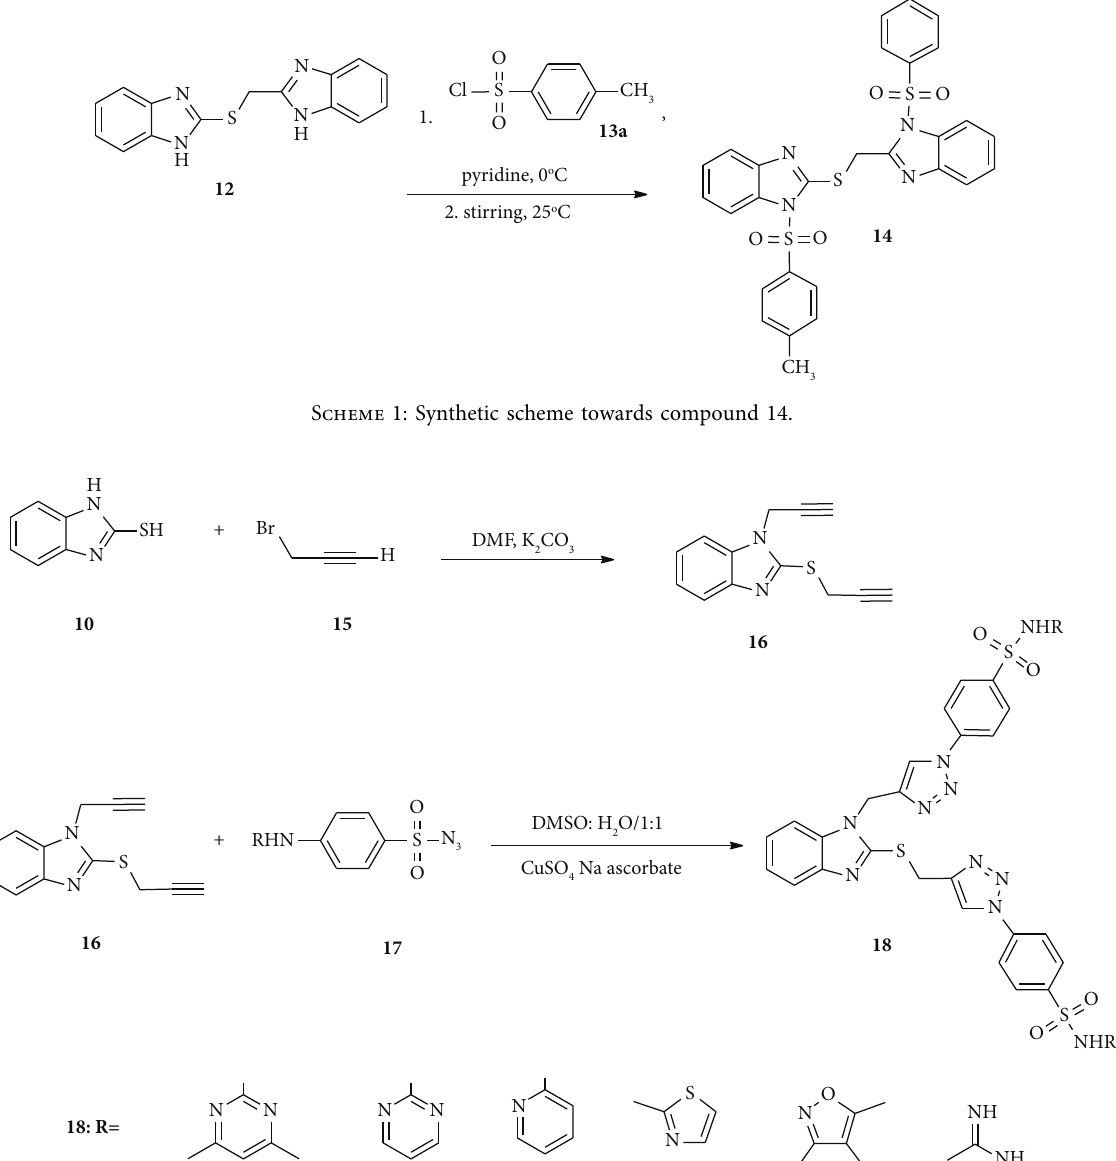
Scheme 2: Synthetic routes towards 1, 2, 3-triazole benzimidazole-sulfonyl